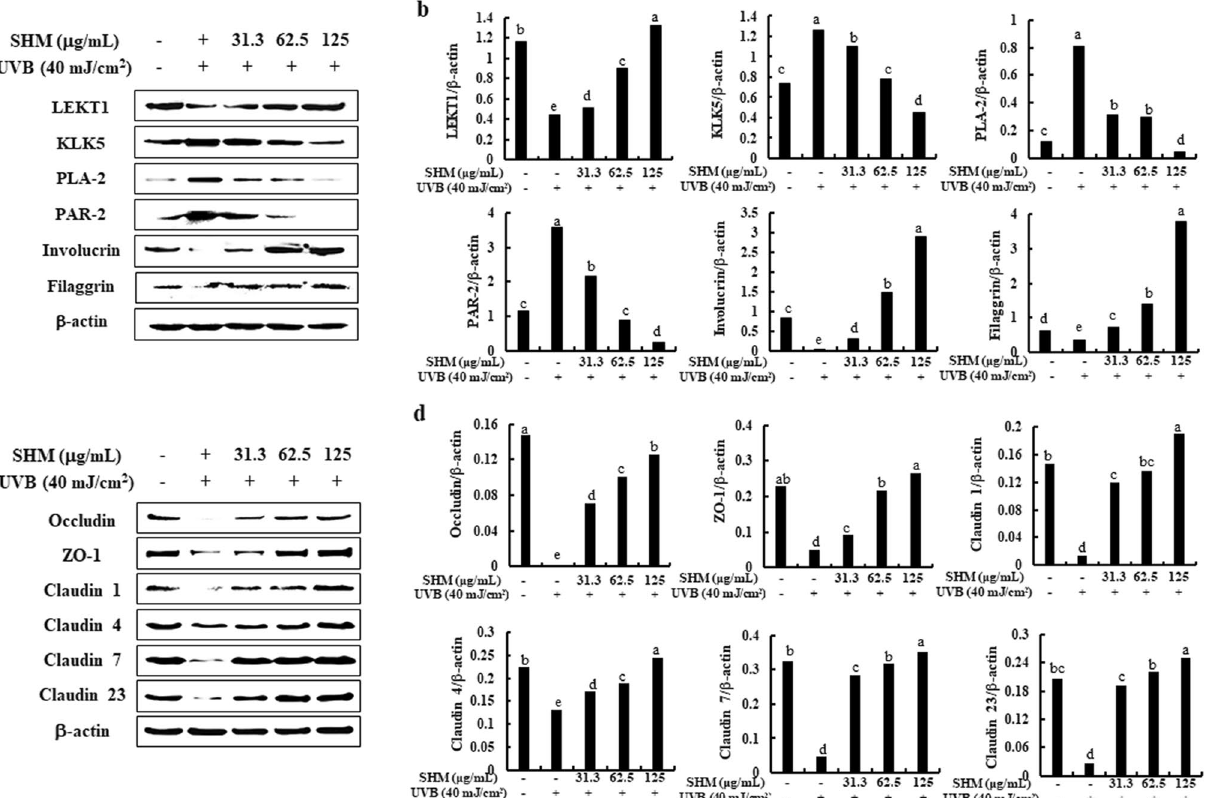
Figure 5. Effects of SHM on UVB exposure-induced skin dryness and skin barrier disruption. ( a ) Skin moisturization-related protein expression levels, ( c ) skin barrier-related protein expression levels, ( b , d ) the density ratio of protein expression was analyzed via Image J software each in comparison to β-actin. All experiments were performed in triplicate. a–e Bars with different letters for each molecule represent significant differences (P <